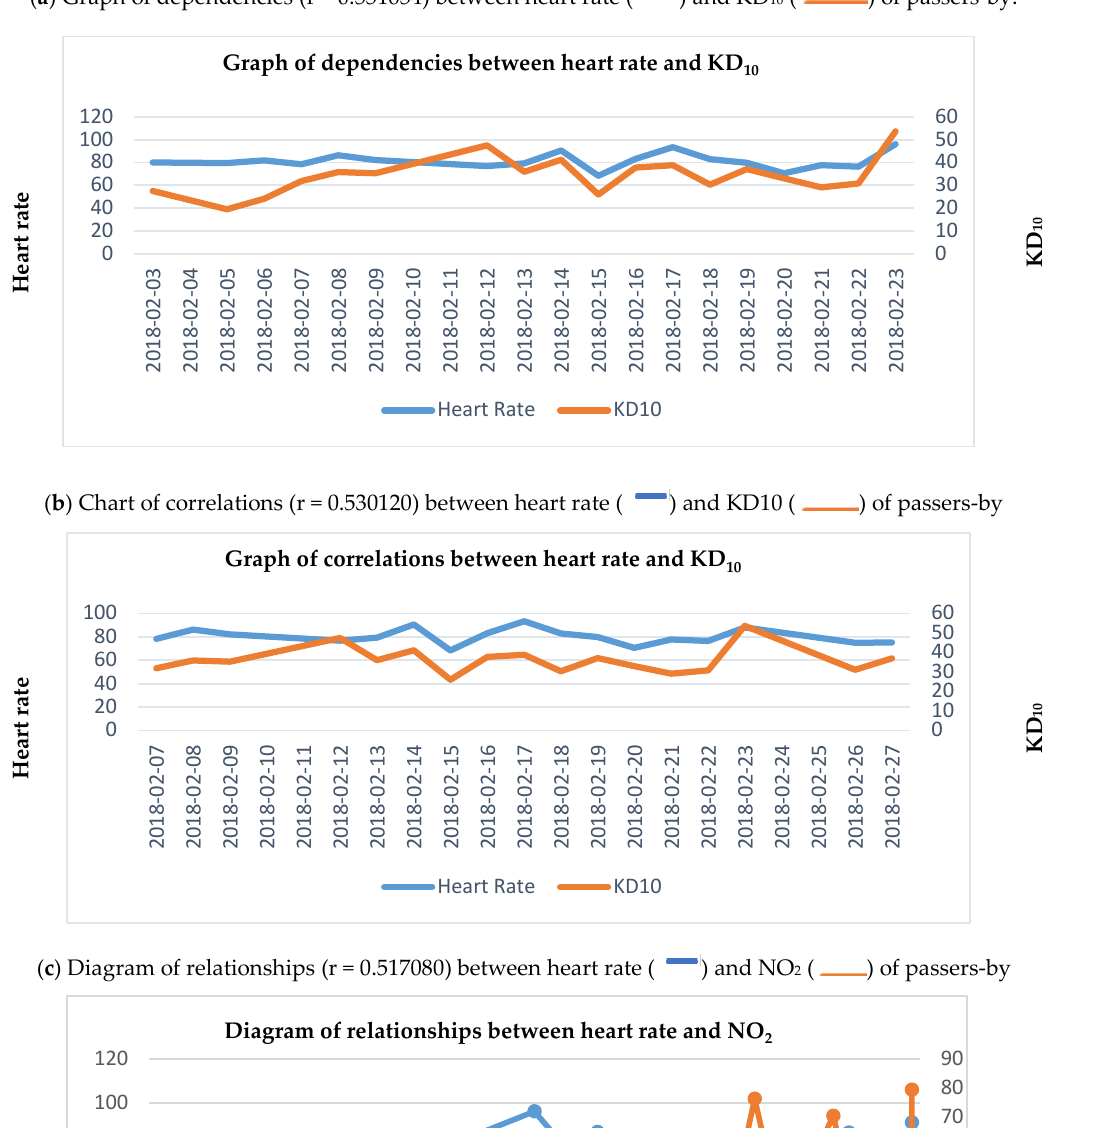
Graph of dependencies between heart rate and KD